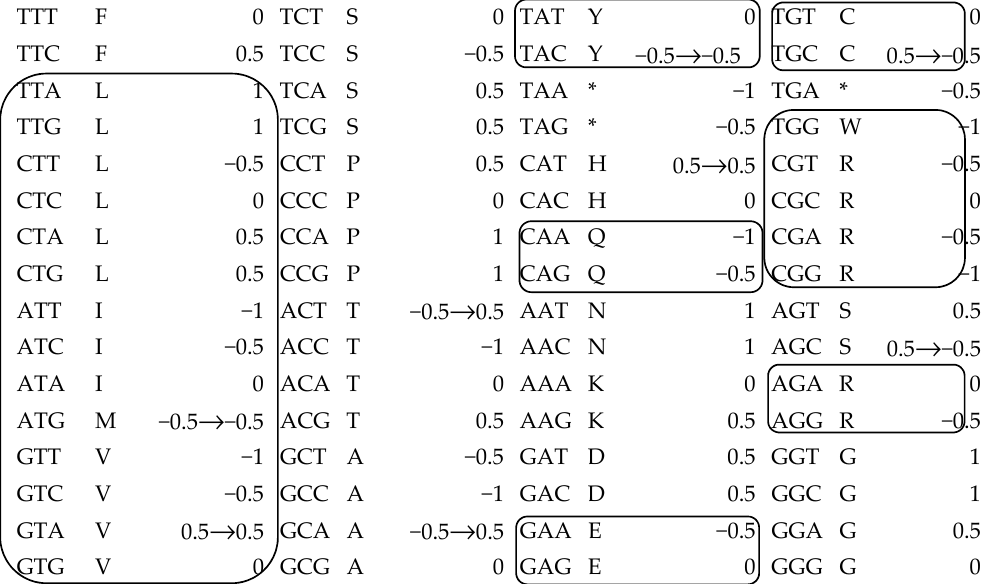
Table 1. The codon directional asymmetry (CDA) of the genetic code’s 64 codons as defined by the purine/pyrimidine divide. Shaded nucleotides: the nucleotide most different from nucleotides at other positions, which determines the codon dominant side. CDA < 0 if the first (5 ′ ) codon position is most different, and CDA > 0 if the third (3 ′ ) position is most different. Frames indicate codons assigned to amino acids aminoacylated by class I tRNA synthetases. CDA of codons ATG, GTA, ACG, GCA, TAC, CAT, TGC and AGC was originally defined by complementarity of nucleotides at extreme codon positions and the midposition nucleotide because the purine/pyrimidine divide is uninformative for these codons regarding CDA. Assuming for these eight codons that codon side dominance is defined by the extreme (first or last position) nucleotide with the weakest complementary interaction defines CDA for these eight codons in this new analysis (* is for STOP). 0 TCT S 0 TAT Y 0 TGT C